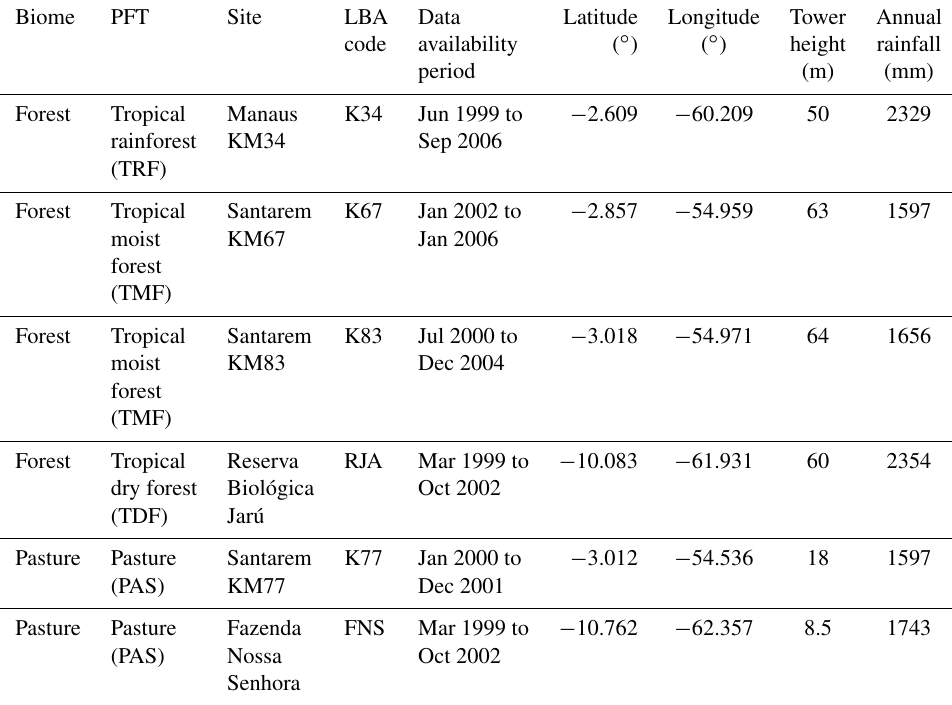
Table 2. Overview of the LBA tower sites. Here, (–) refers to (S) and (W) for latitude and longitude, respectively. Biome PFT Site LBA Data Latitude Longitude Tower Annual code availability ( ◦ ) ( ◦ ) height rainfall period (m) (mm) Forest Tropical